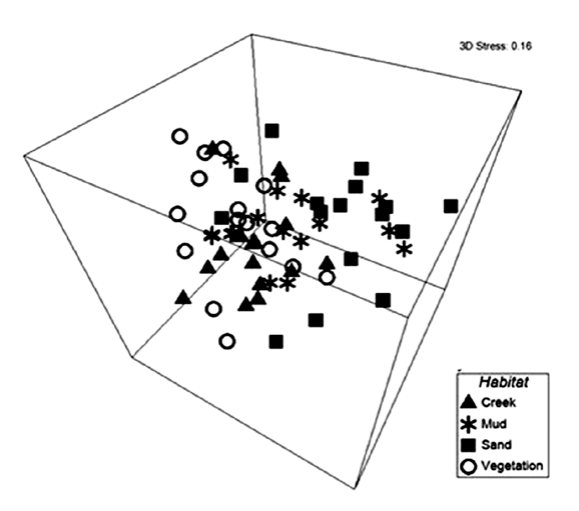
Fig. 4. – A three-dimensional nMDS plot of similarity of species abundance among habitat types in the Swartkops Estuary